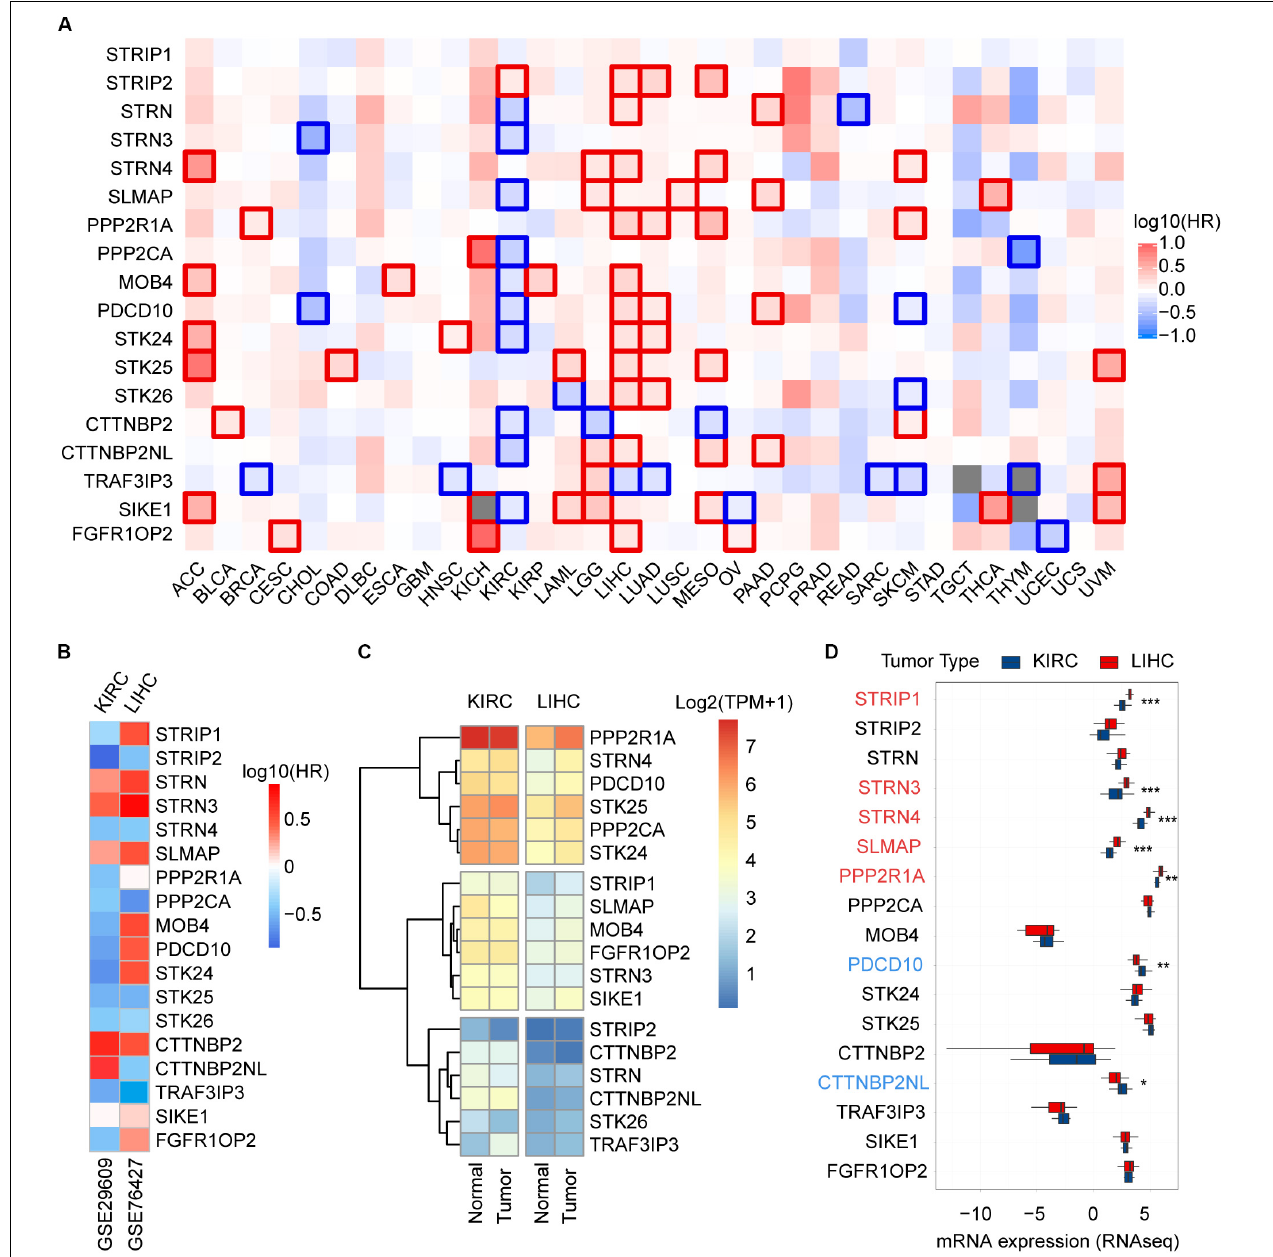
FIGURE 3 | Prognostic power and expression level of the STRIPAK genes in cancers. (A) Kaplan-Meier analysis of overall survival according to the expressions of STRIPAK genes in TCGA data using GEPIA online tool without false discovery rate (FDR) adjustment. The boxes with framed indicated significant results ( p < 0.05). (B) Survival analysis of STRIPAK genes using data of GSE29609 and GSE76427. (C) Expression level of STRIPAK genes in normal and tumor tissues of KIRC and LIHC. Log2(TPM+1) of TCGA data were showed. TPM is short for transcript per million. (D) Differences in mRNA expression between cell lines of LIHC and KIRC according to the CCLE database. Genes in color depicts statistical significance, genes in red depicts the higher expression level of liver cancer cell lines, and genes in blue depicts that kidney cancer cell lines expressed higher. * p < 0.05, ** p < 0.01, *** p < 0.001.